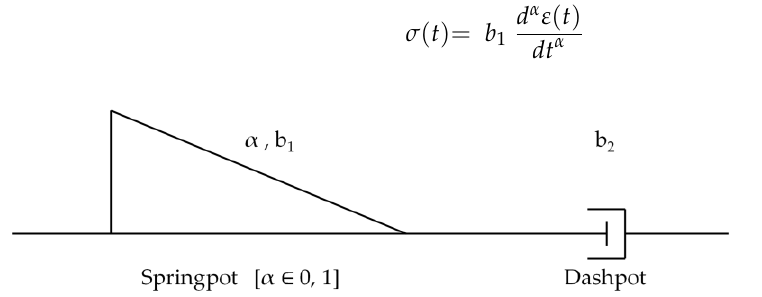
Figure 3. Creep-recovery proposed model: springpot in series with dashpot.